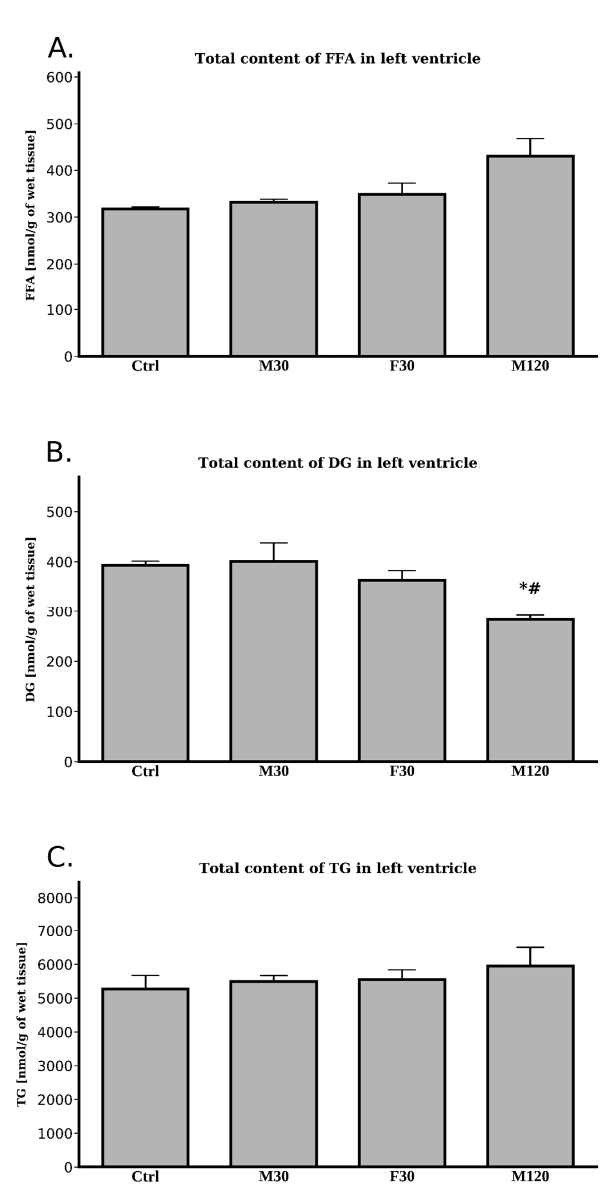
Figure 3. E ff ects of treadmill running on the total lipids content: FFA ( A ) DG ( B ) TG ( C ) in the left ventricle. Data are expressed as mean ± SEM. * p < 0.05 di ff erence vs. control (Ctrl); # p < 0.05 di ff erence M120 vs. M30. Diacylglycerol (DG), triacylglycerol